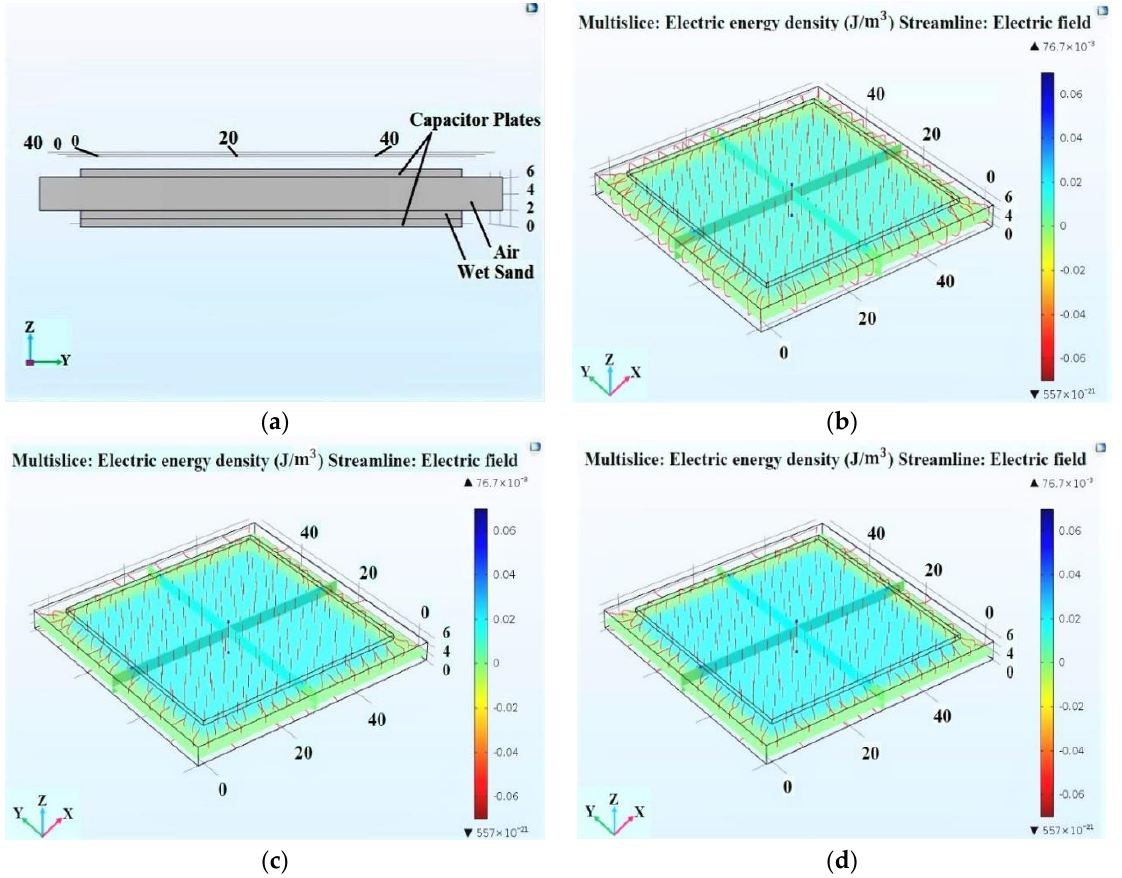
Figure 21. ( a ) Single module capacitor incorporates with wet sand in ANYSYS Maxwell Simulation. ( b ) Material electric energy density (for wet sand) with coating thickness of 0 mm. ( c ) Material electric energy density (for wet sand) with coating thickness of 0.5 mm. ( d ) Material electric energy density (for wet sand) with coating thickness of 1 mm.